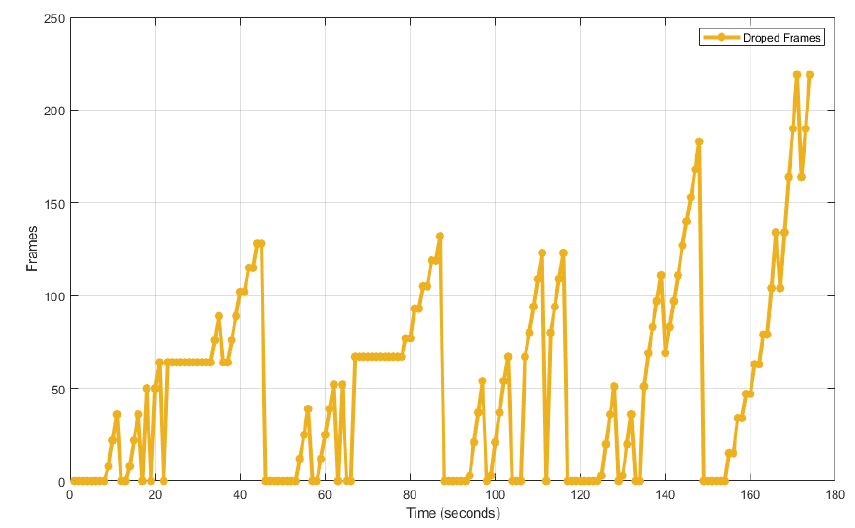
Figure 4. Results of dropped frames network feature experimentation trials.